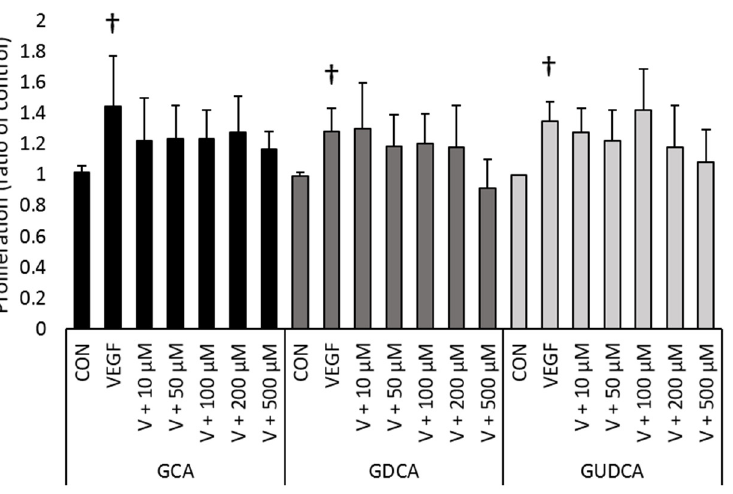
Figure 2. Glycine-conjugated bile acids do not significantly inhibit VEGF-induced CEC proliferation. RF/6A cell proliferation was induced with 100 ng/mL VEGF (V). Cells were treated with GCA, GDCA, or GUDCA (10, 50, 100, 200, or 500 µM) and their ability to inhibit cell proliferation was evaluated with a BrdU-based colorimetric assay. Absorbance levels were normalized to average absorbance levels of untreated control. Normalized absorbance levels of cells treated with VEGF were compared to untreated controls for each set of experiments (†: GCA, p = 0.023; GDCA, p = 0.0050; GUDCA, p = 0.0011). Normalized absorbance levels of cells treated with GCA, GDCA, or GUDCA were compared to normalized levels of cells treated with VEGF. No concentration of GCA, GDCA, or GUDCA significantly inhibited proliferation compared to cells treated with VEGF alone. Data are presented as mean ± standard deviation (n = 6).